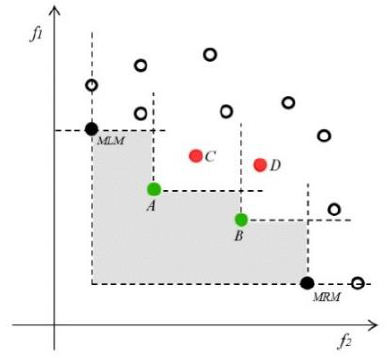
Figure 9. Pareto front of non-dominated